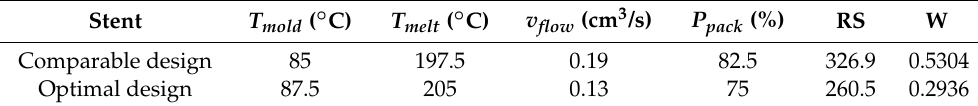
Table 2. Comparison of the two design